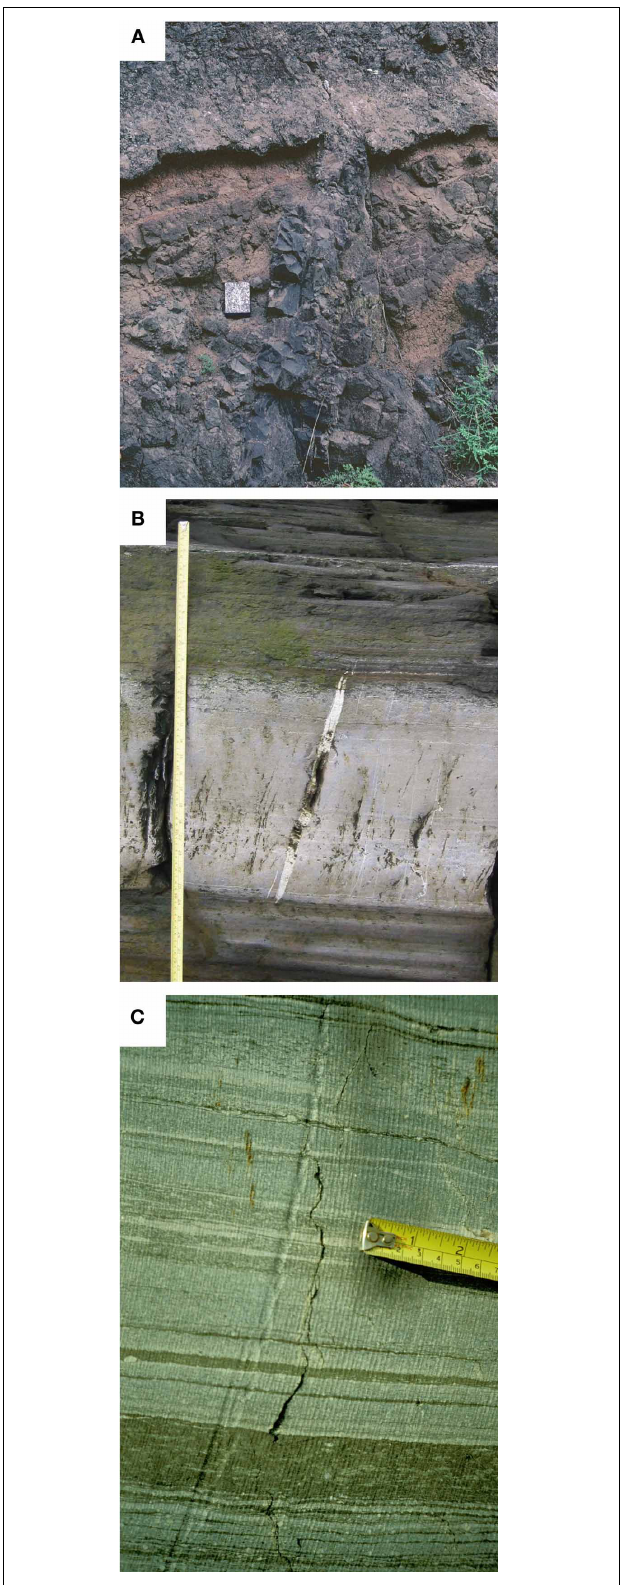
FIGURE 12 | Arrested hydrofractures in layered rocks (cf. Brenner, 2003). (A) Arrested, blunt dyke tip in a vertical section at a road cut in Tenerife, at the contact between a pyroclastic rock layer below and a basaltic lava flow above. View west; the notebook provides a scale. (B) Arrested calcite vein at Kilve, Somerset coast, Southwest England. The vein is arrested at the contacts of a limestone layer to shale layers above and below. View east-southeast; the visible part of the measuring steel tape is 0.5m long. (C) Arrested open joint in gneiss at a road cut in the city of Bergen, West Norway. The joint is arrested at the contact of leucosome layers to an amphibolitic melanosome layer. View north-northeast; visible part of the measuring steel tape is 0.065m